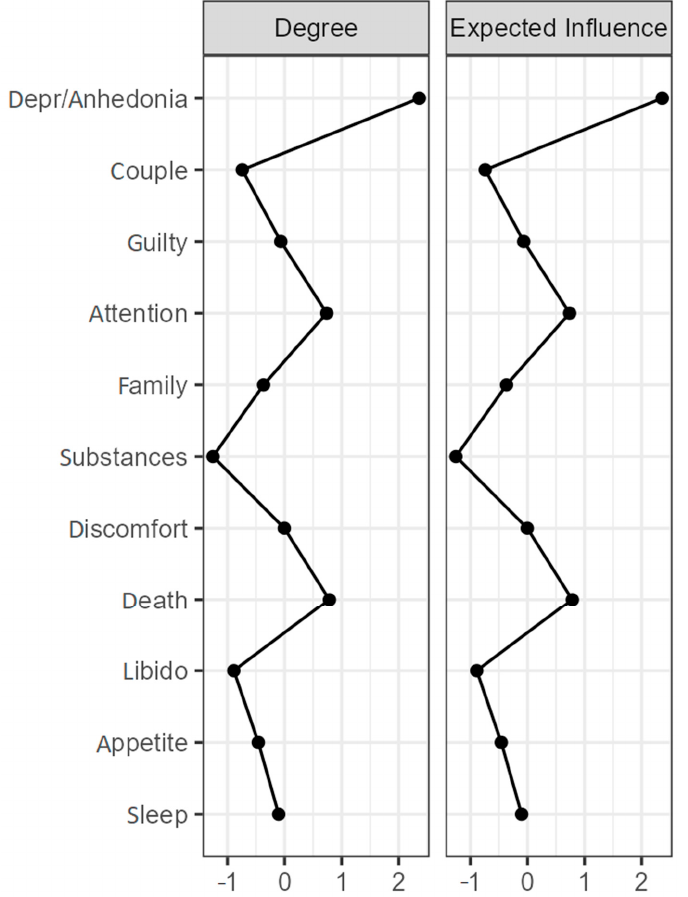
Figure A3. Centrality measures for the DCET factors for the moment ‘year’ (z-scores). Note — Depr/Anhedonia: Depressive Affect and Anhedonia form one single factor in the temporal moment “year”.